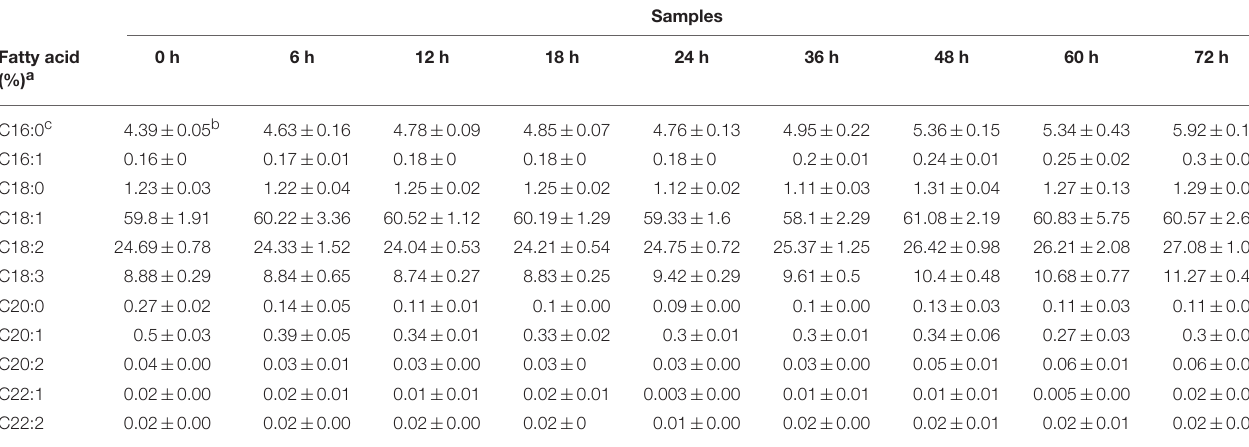
TABLE 1 | Change of FA contents for seed oil during germination and seedling establishment.